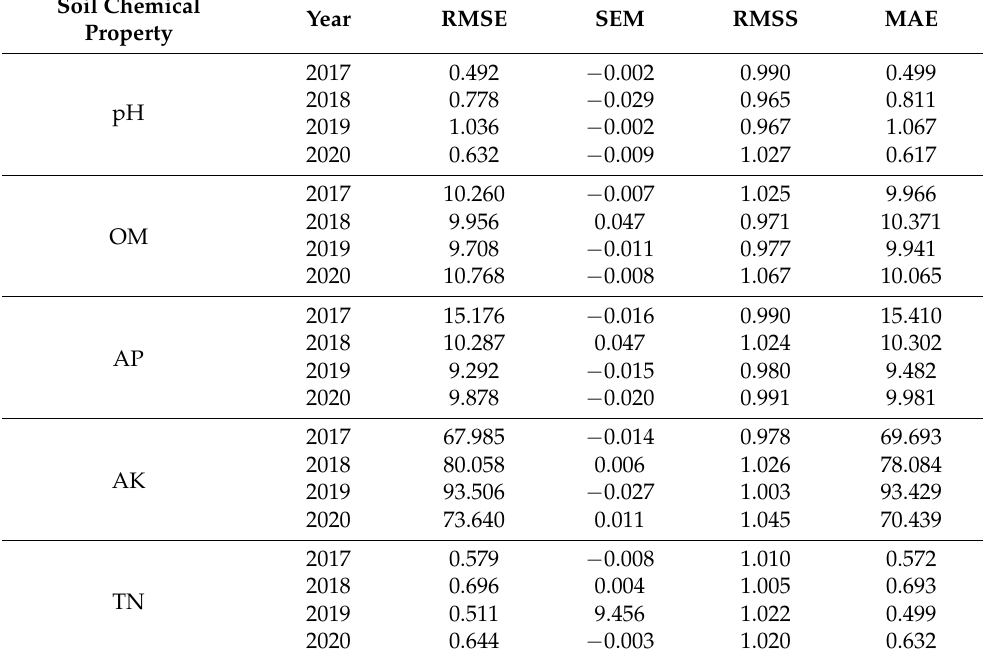
Table 2. Accuracy of soil data interpolation in Baokang County.